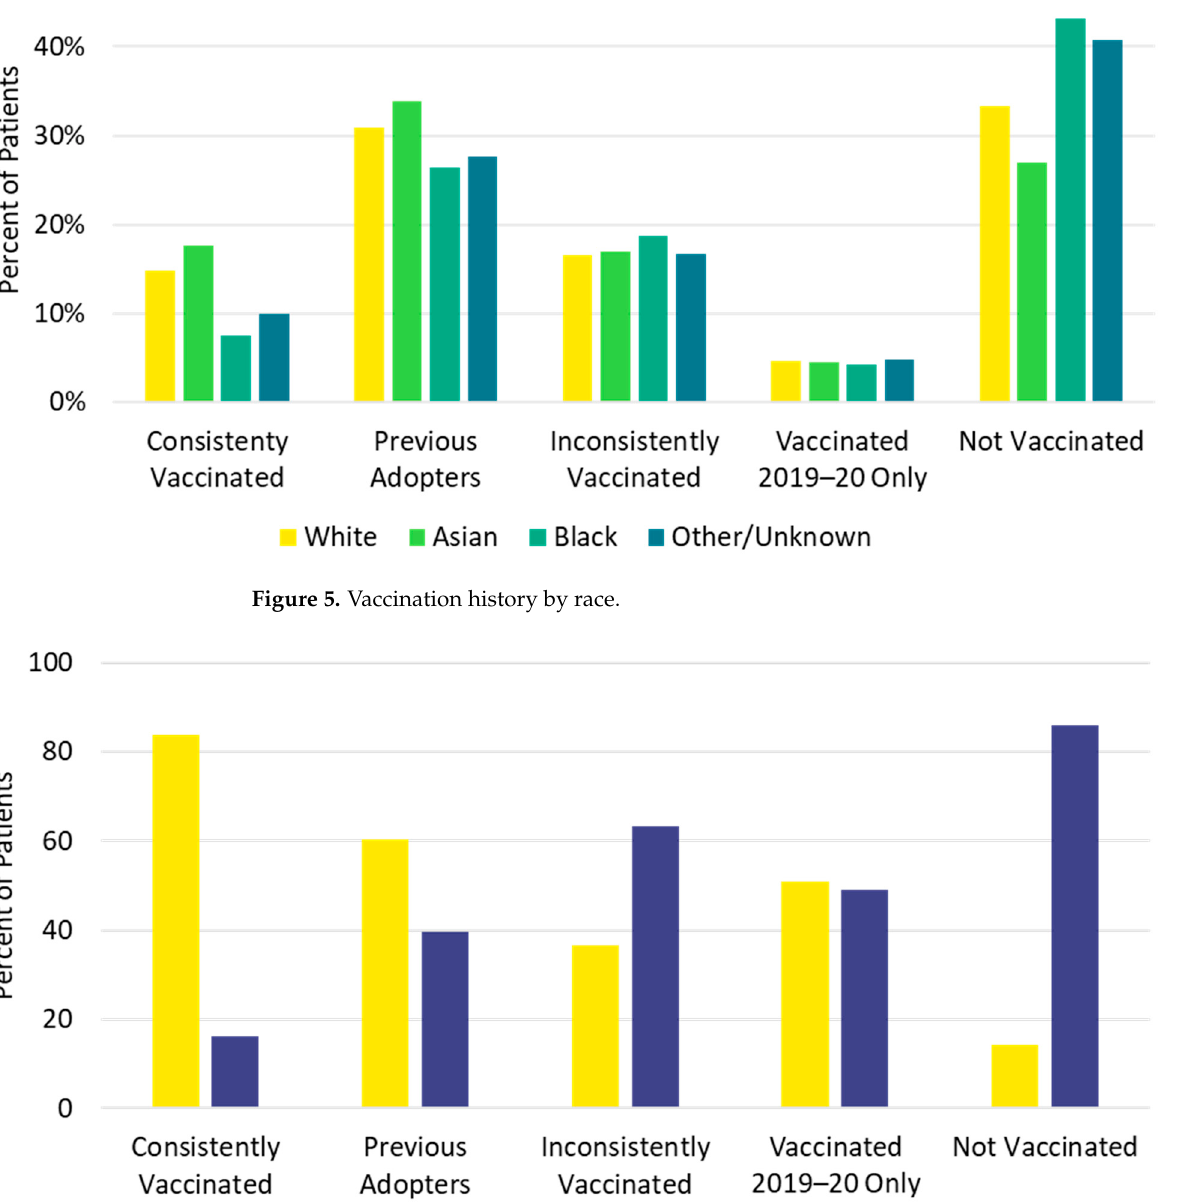
Figure 6. Influenza vaccination history and vaccination status for the 2020–2021 season.